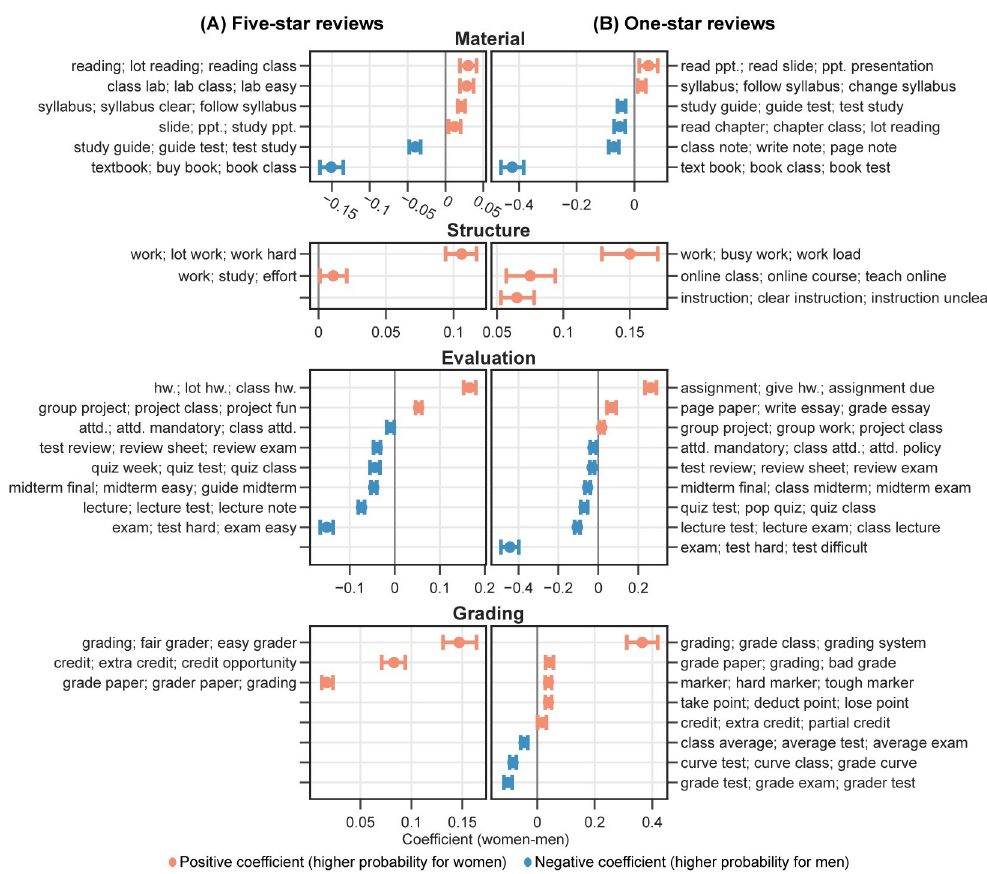
Fig 8. Regression analysis of predicted possibilities from topic modeling in (A) five-star and (B) one-star reviews by course- level topic dimensions. Subject dimension is excluded. Figure encodings have the same meanings as Fig 7. Only statistically significant results are shown. ppt. = powerpoint; hw. = homework; attd. =